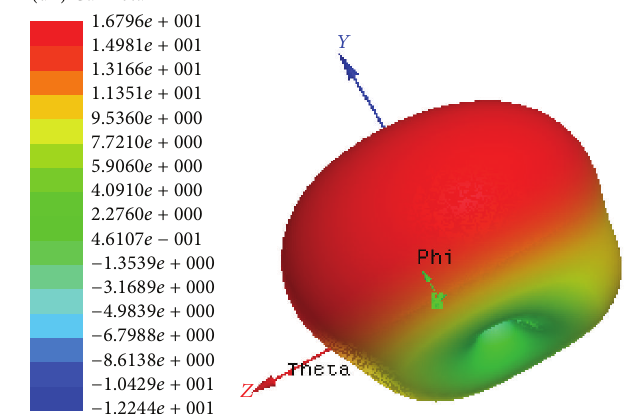
Figure 7: 3D model of the radiation pattern of the printed Z-shaped